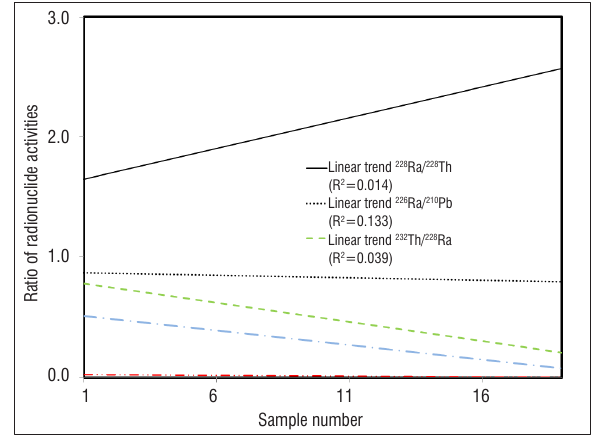
Figure 2. The ratio of activity concentrations for 238 U, 235 U, 232 Th and their progeny in phosphogypsum from the Lowveld region of South Africa. The Anderson–Darling test has been shown to give appropriate empirical ) and internal (H ) hazard indices, Figure 1: The calculated external (H ex i distribution function statistics for detecting departure from normality, activity concentration index (I ) and the radium equivalent (Ra ) eq γ even with small samples ( n< 25). 27 The test was performed on a set of in phosphogypsum from the Lowveld region of South Africa. data to evaluate their fit to a chosen distribution pattern. For the Gaussian Error lines indicate the standard deviation. distribution test, the statistics are based on the squared difference between the normal and the empirical data. If the calculated p -value is less than a chosen alpha (one minus the confidence interval), the null hypothesis, that the data come from that distribution, is rejected. The Anderson–Darling (AD) test was performed on the radioactive nuclide activity concentration data using the Minitab ® 16 statistical software to evaluate the distribution pattern of the activity concentration in the LSA phosphogypsum. The results obtained are presented in the probability plot in Figure